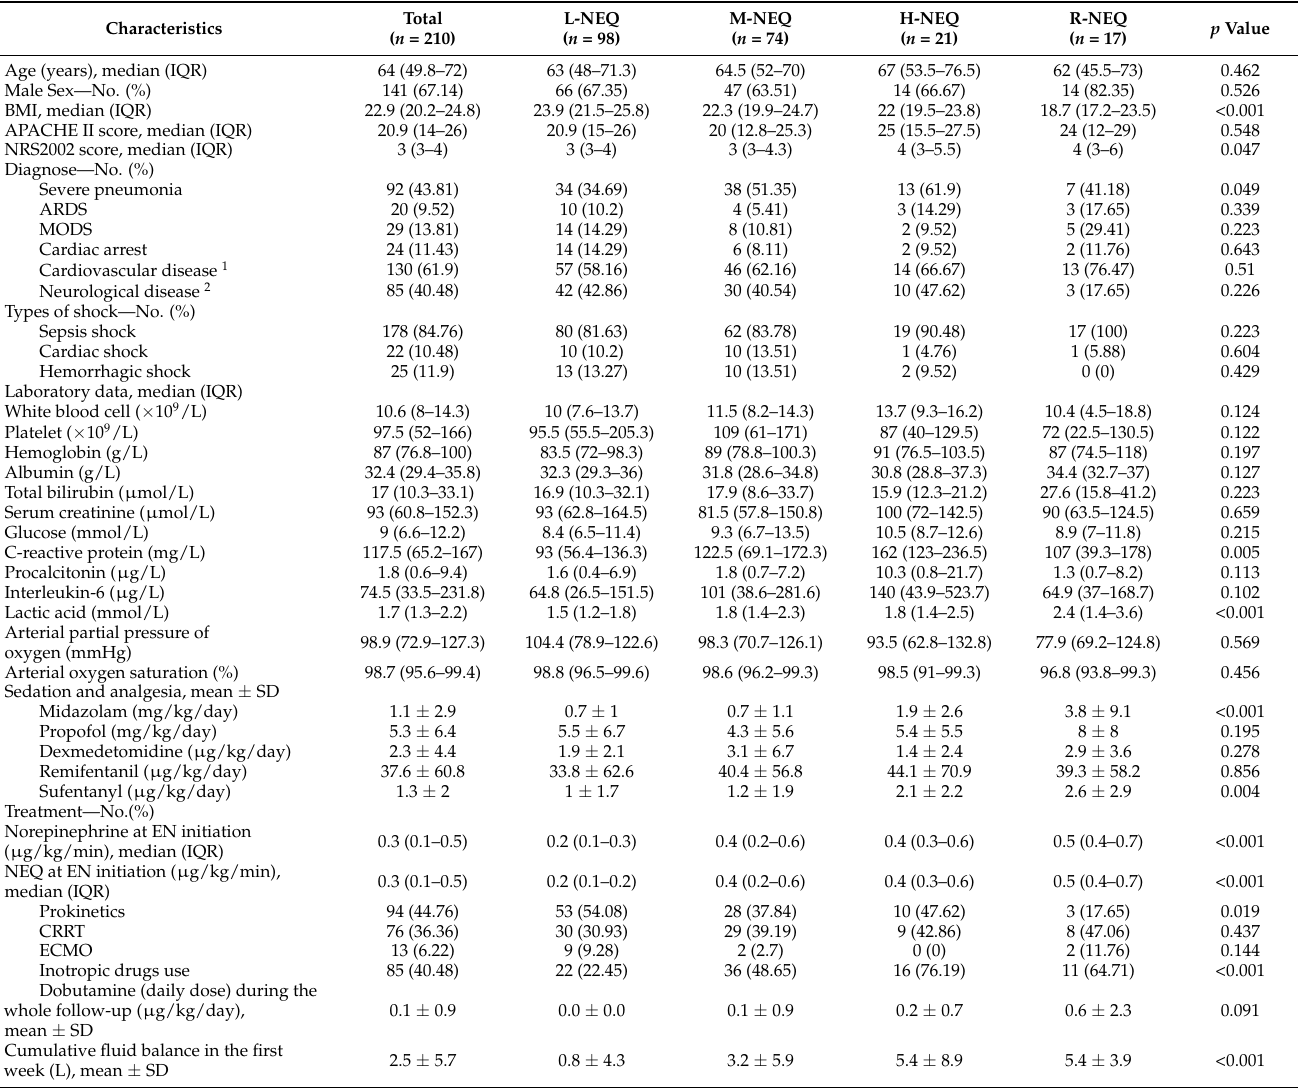
Table 1. Baseline characteristics and follow-up by NEQ Trajectory